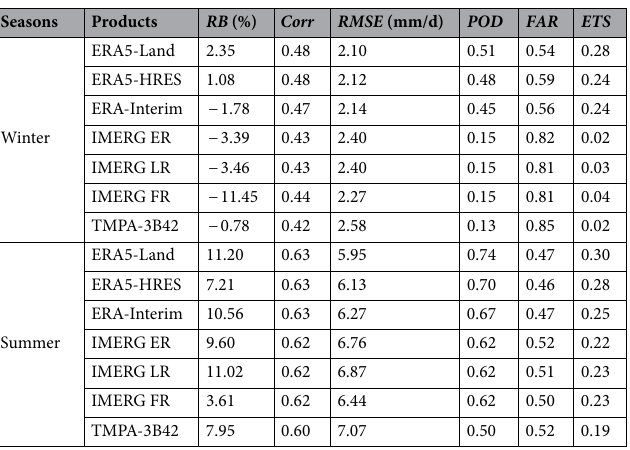
Table 3. Summary of evaluation metrics for the precipitation products in the winter and